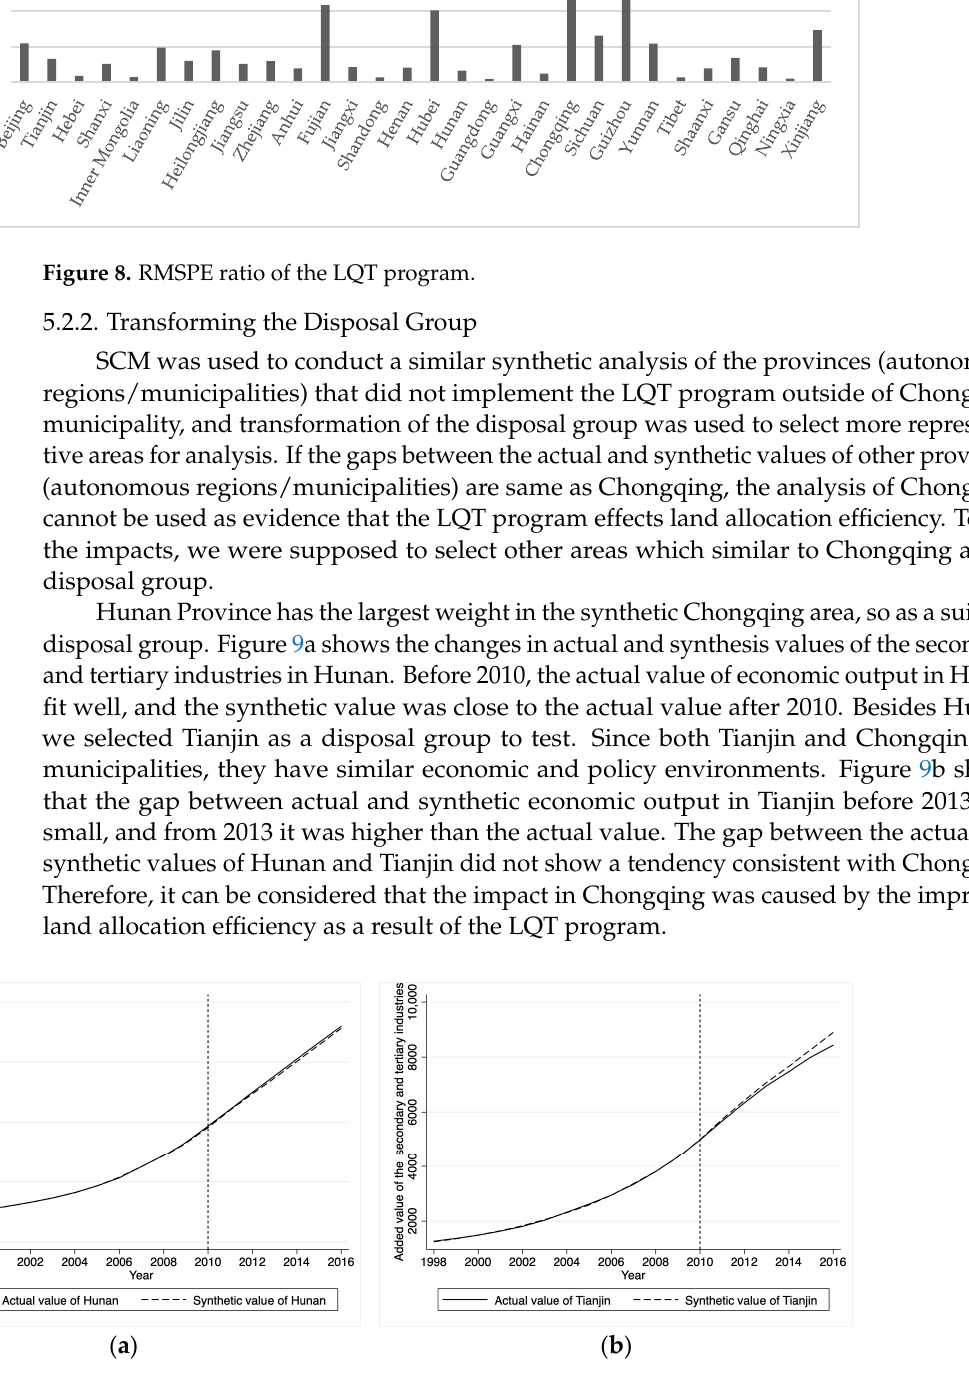
( b ) Figure 7. Distribution of prediction gaps: ( a ) Chongqing and other areas; ( b ) Chongqing and the valid fitting provinces. The distribution of the policy effect gap after removing the six provinces (autono- mous regions/municipalities) is shown in Figure 7b. Before 2010, the economic output gap between Chongqing (black line) and other provinces (autonomous regions/municipali- ties) was not large, but after 2010, the gap gradually widened, and the difference in added value of the secondary and tertiary industries was higher in Chongqing than in other provinces (autonomous regions/municipalities). The results show that the LQT program improved the economic output of Chongqing construction land. Assuming the LQT pro- gram had no effect, the probability of estimating a gap of the magnitude for Chongqing under a random permutation of the intervention in our data is 4.2%. This is similar to the statistical inference of significance level; therefore, it can be considered that the effect of the LQT program on economic output at the 5% level is significant. Another way to evaluate the relative difference between the virtual policy effect in each province and the actual policy effect in Chongqing is to compare the ratio of RMSPE before and after the reform. RMSPE reflects the goodness of the synthetic samples’ fit. Before the LQT program, smaller 𝑅𝑀𝑆𝑃𝐸 (cid:3043)(cid:3045)(cid:3032) indicate better fitness of a province’s value.